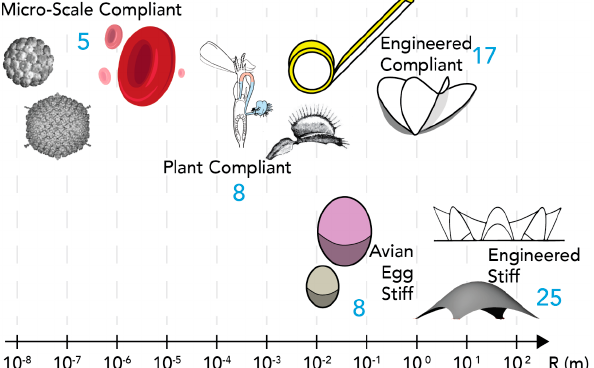
Figure 1. Varying size / scale (R) of the five types of shells included in the study. The number of typologies for each type of shell is shown in blue.